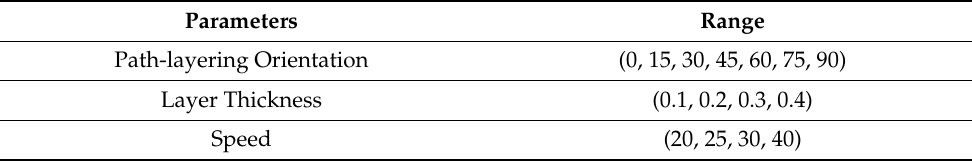
Table 2. AM-ed Processing Variables for Designing the Morphing